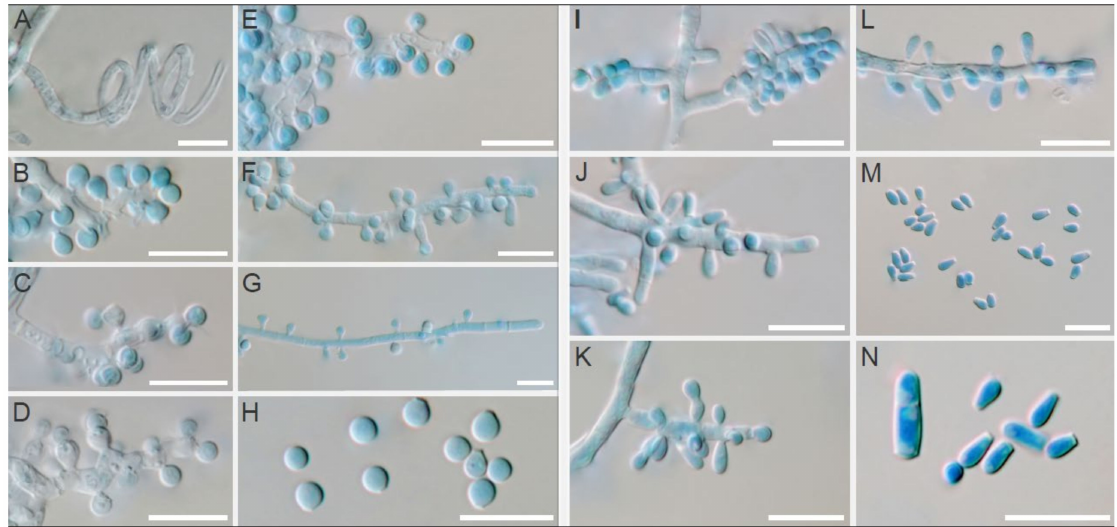
Figure 6. Micromorphology of Trichophyton mentagrophytes (left; A – H ) in comparison with T. erinacei (right; I – N ) isolated from European hedgehogs in France. Spiral hyphae of T. mentagrophytes ( A ); branched or unbranched conidiophores bearing small round microconidia of T. mentagrophytes ( B – G ); free small round microconidia of T. mentagrophytes ( H ); simple conidiophores bearing microconidia of T. erinacei ( I – L ); free clavate microconidia and two-celled macroconidia of T. erinacei ( M , N ). Scale bars = 10 µ